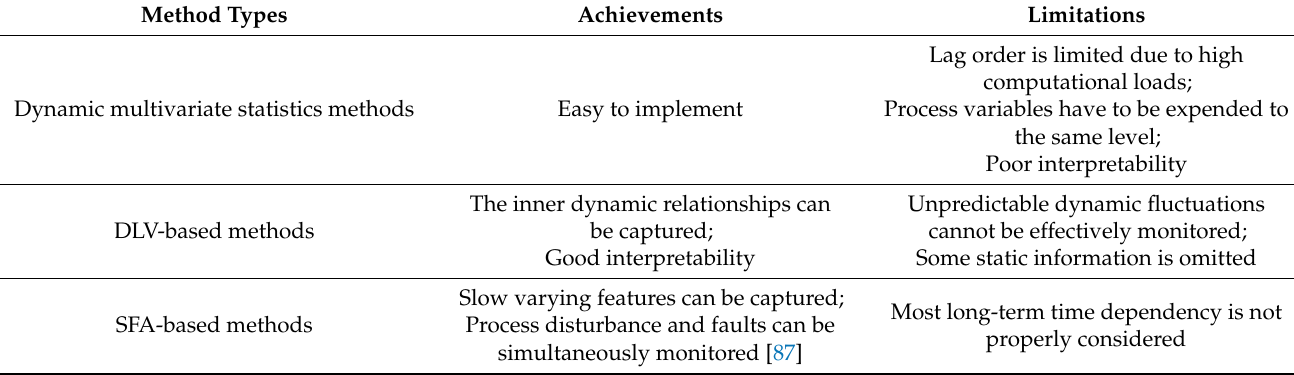
Table 4. Comparative analysis of dynamic process monitoring